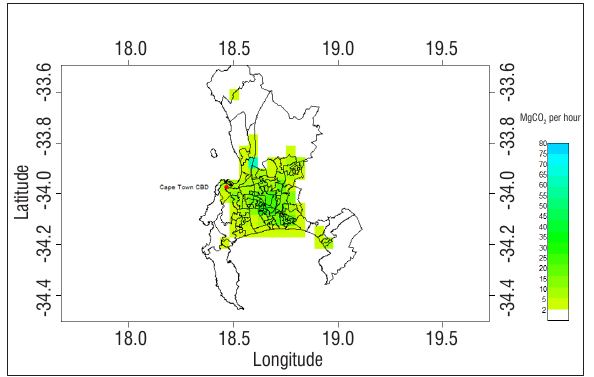
emissions from 18:00 to 19:00 during a week- Figure 9: Aggregated CO 2 day in March 2012.